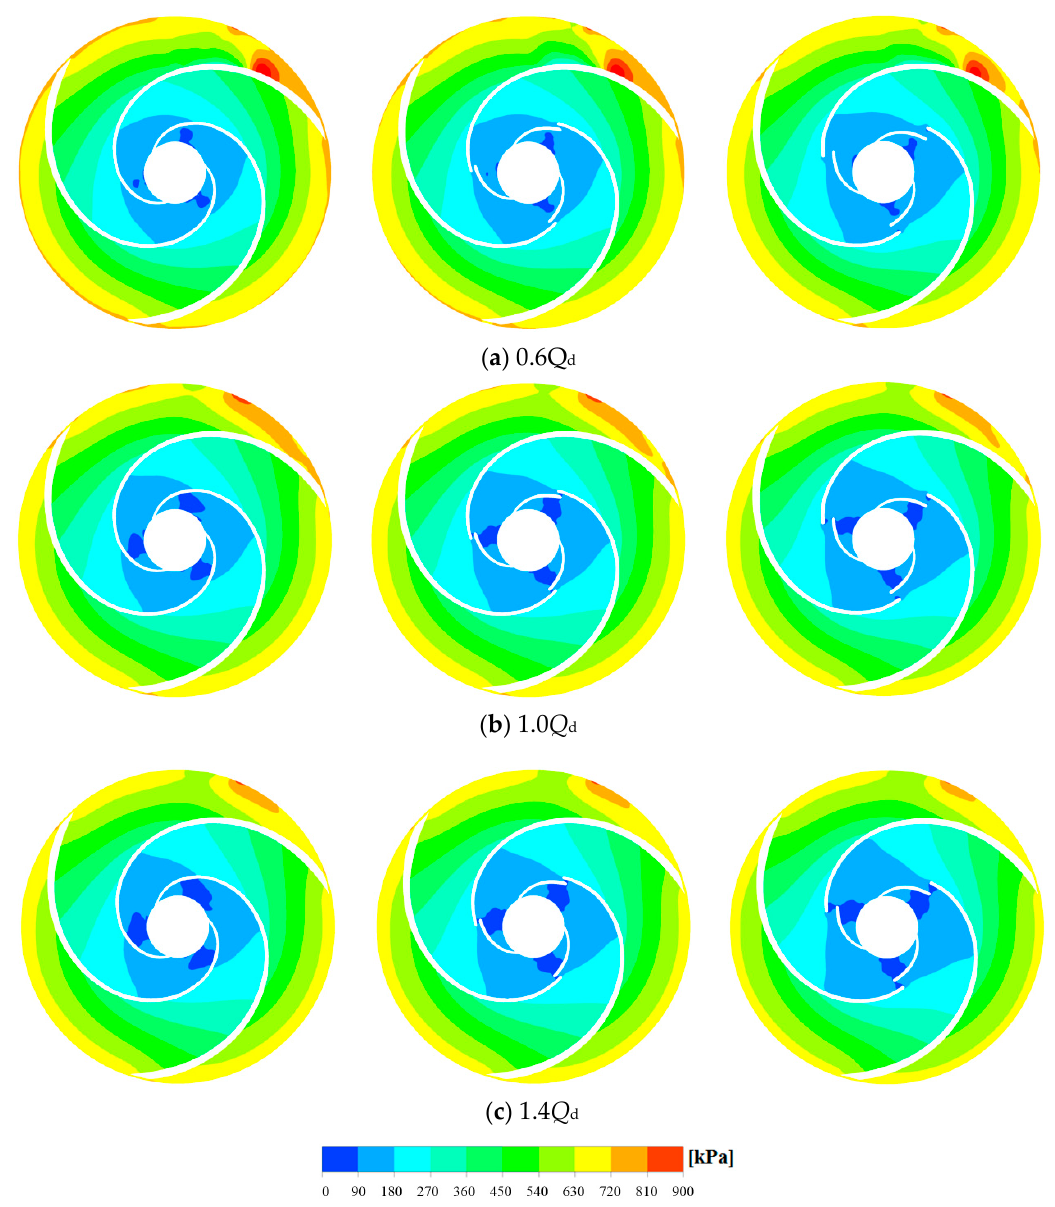
Figure 9. Pressure distribution diagram of middle section of impeller. From left to right: Model 1, Model 2, and Model 3.